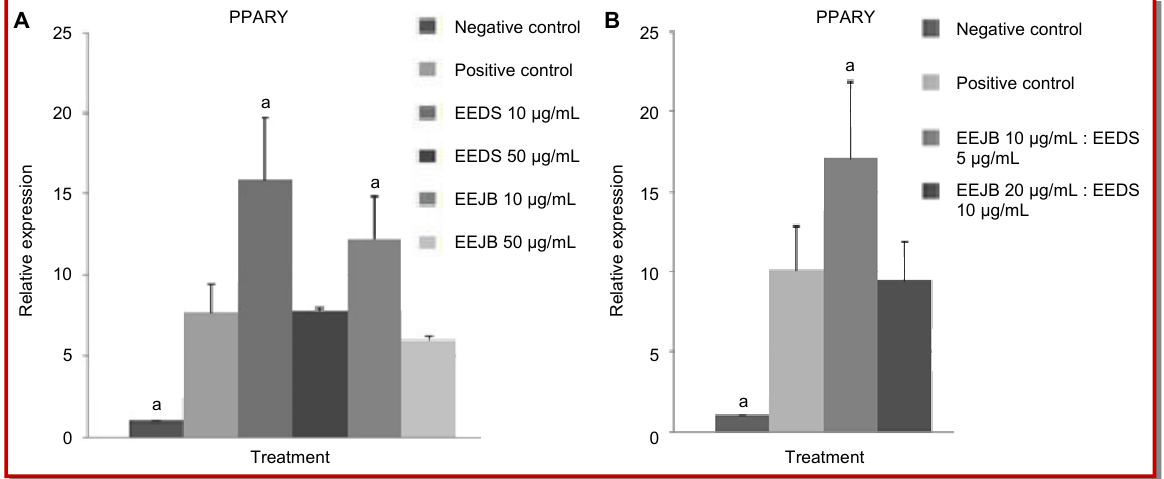
Figure 1: Relative expression of adipogenesis-related gene, PPAR (cid:452) i n 3T3-L1 cells. (a) Effects of single ethanol extract of Detam 1 soybean (EEDS) or ethanol extract of Jati belanda leaves (EEJB) treatments in concentration of 10 µg/mL and 50 µg/mL; (b) Ef- fects of combination of ethanol extract of Jati belanda leaves and ethanol extract of Detam 1 soybean treatments in concentration of 10 µg/mL, 5 µg/mL and 20 µg/mL, 10 µg/mL (*p<0.05, significant compared to positive control, Duncan post-hoc